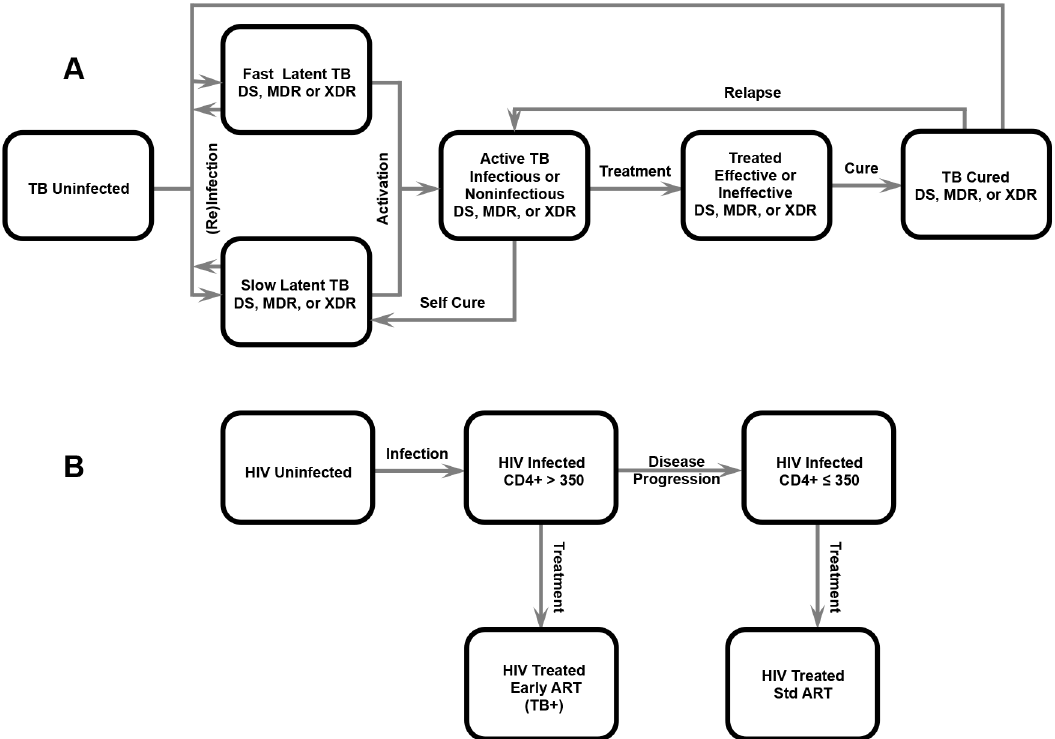
Fig 1. Model Diagrams. Model diagrams of (A) TB transmission dynamics and (B) HIV transmission dynamics. Although depicted separately, modeled individuals had a status for each disease. Drug resistance ( i . e ., drug susceptible [DS], multidrug-resistant [MDR], and extensively drug-resistant [XDR] TB) was also included in the model. Model parameters and equations are detailed in S1